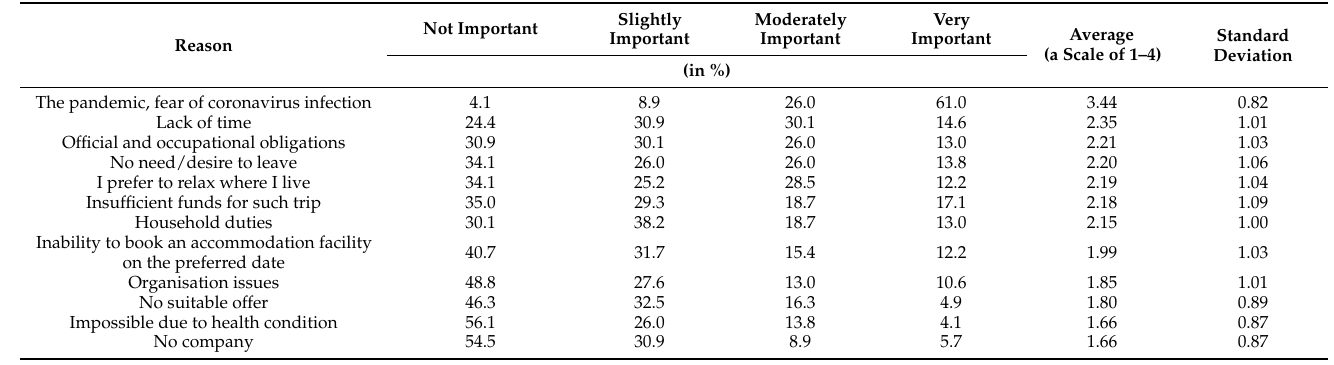
Table 3. Reasons preventing or discouraging the respondents from taking trips in 2020 ( n =